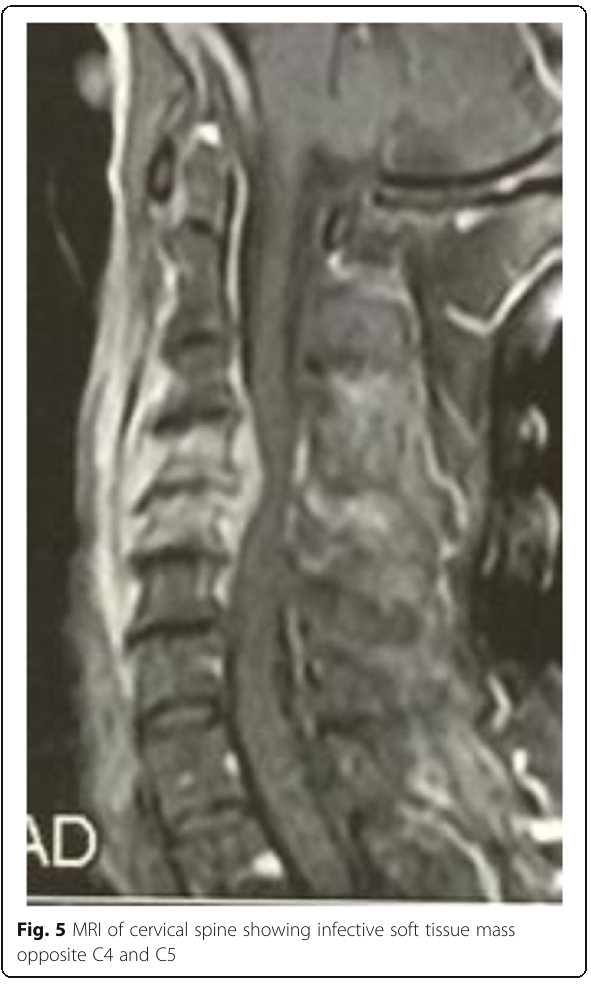
Fig. 5 MRI of cervical spine showing infective soft tissue mass opposite C4 and C5